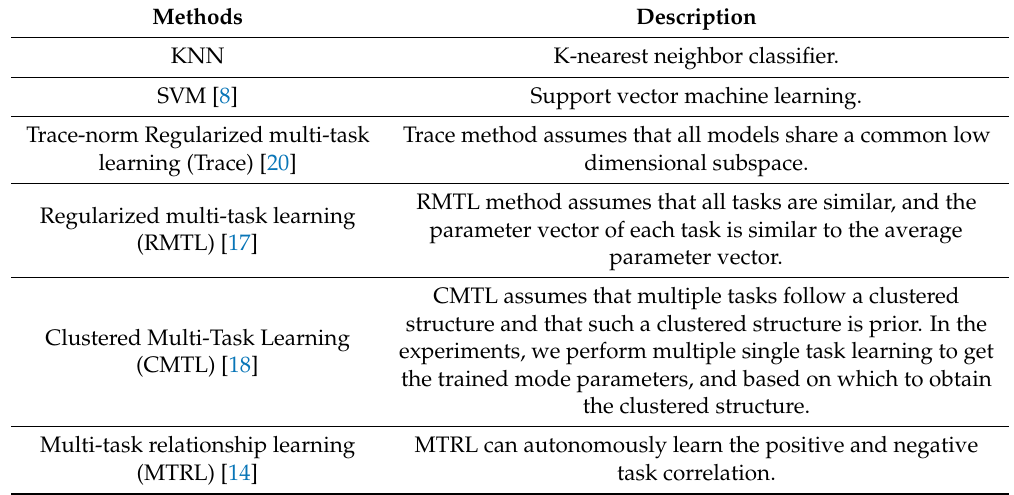
Table 1. The reference methods to be studied.